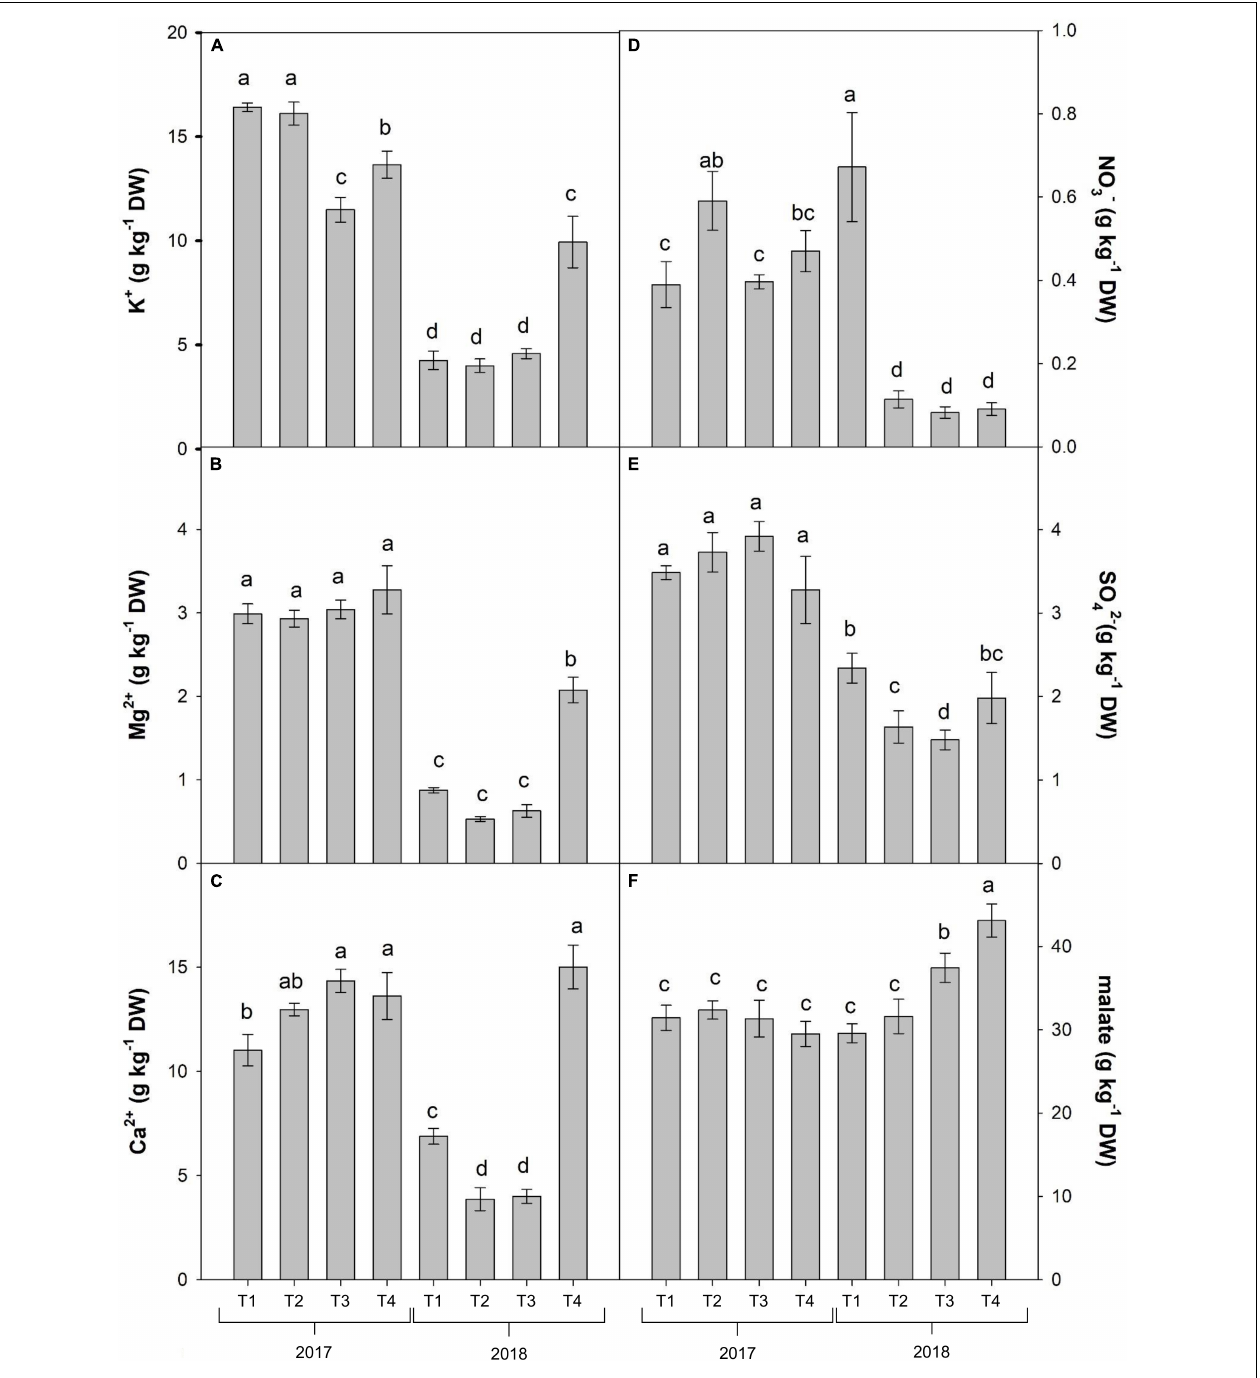
FIGURE 6 | Combined effects of year and foliar treatments on leaf content of potassium (A) , magnesium (B) , calcium (C) , nitrate (D) , sulfate (E) , and malate (F) of V. vinifera “Aglianico” vines (mean ± SE). Different letters indicate significant differences according to Duncan’s multiple-range test ( P ≤ 0.05). [T1 – only industry water mixture of copper oxychloride; T2 – industry water mixture of copper oxychloride plus Trym R (cid:13) ; T3 – half dose of copper oxychloride water mixture; T4 – half dose of copper oxychloride water mixture plus Trym R (cid:13) ].